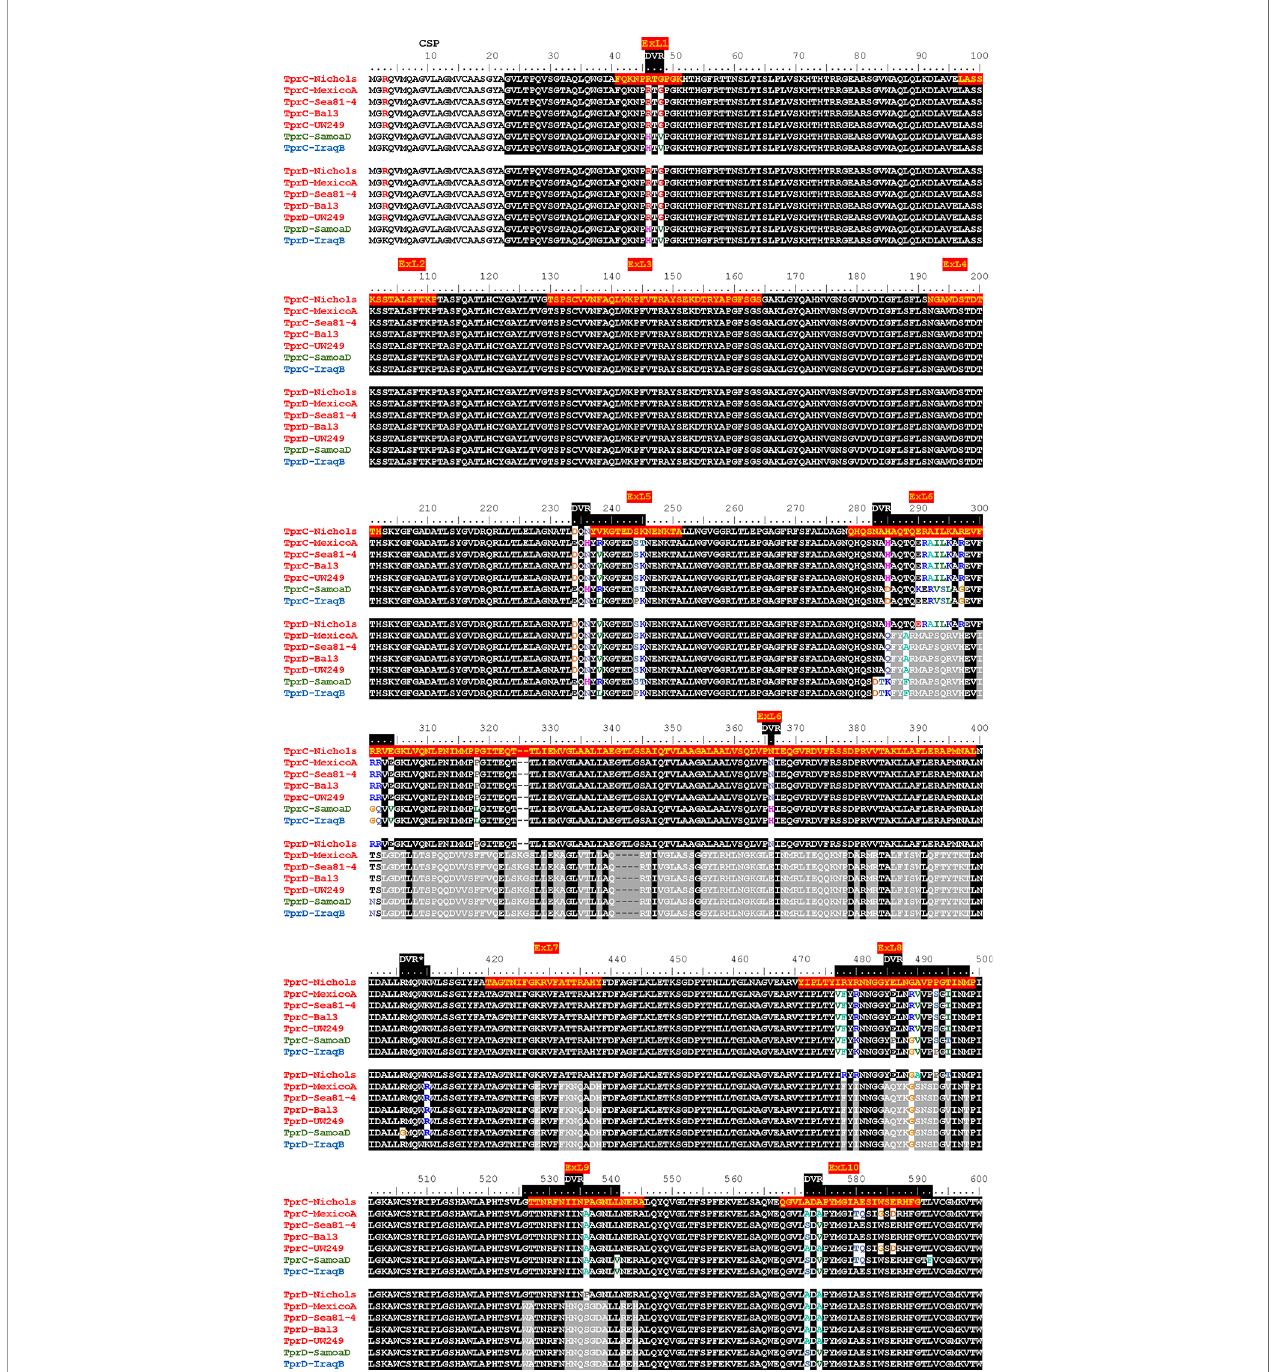
FIGURE 1 | Alignment of amino acid sequences of the TprC and TprD/D 2 variants. Tp. subsp. pallidum strains (Nichols, MexicoA, Sea81-4, Bal3, and UW249) are indicated in red font on the left of the sequence. The Tp subsp. pertenue strain (SamoaD) is in green font, and the Tp subsp. endemicum (IraqB) strain is in blue font. The Chicago and Bal73-1 TprC and TprD sequences (not shown) are identical to the Nichols strain. The MexicoA, Sea8-14, Bal3, UW249, SamoaD, and IraqB strains harbor a TprD 2 variant within the tprD locus. CSP, predicted cleavable signal peptide; ExL, External Loop. Amino acids encompassing the ExLs predicted by AlphaFold2 are highlighted in red with yellow text only in the top sequence. DVR, Discrete Variable Region. DVRs are highlighted in black along the ruler. *Indicates a DVR found in